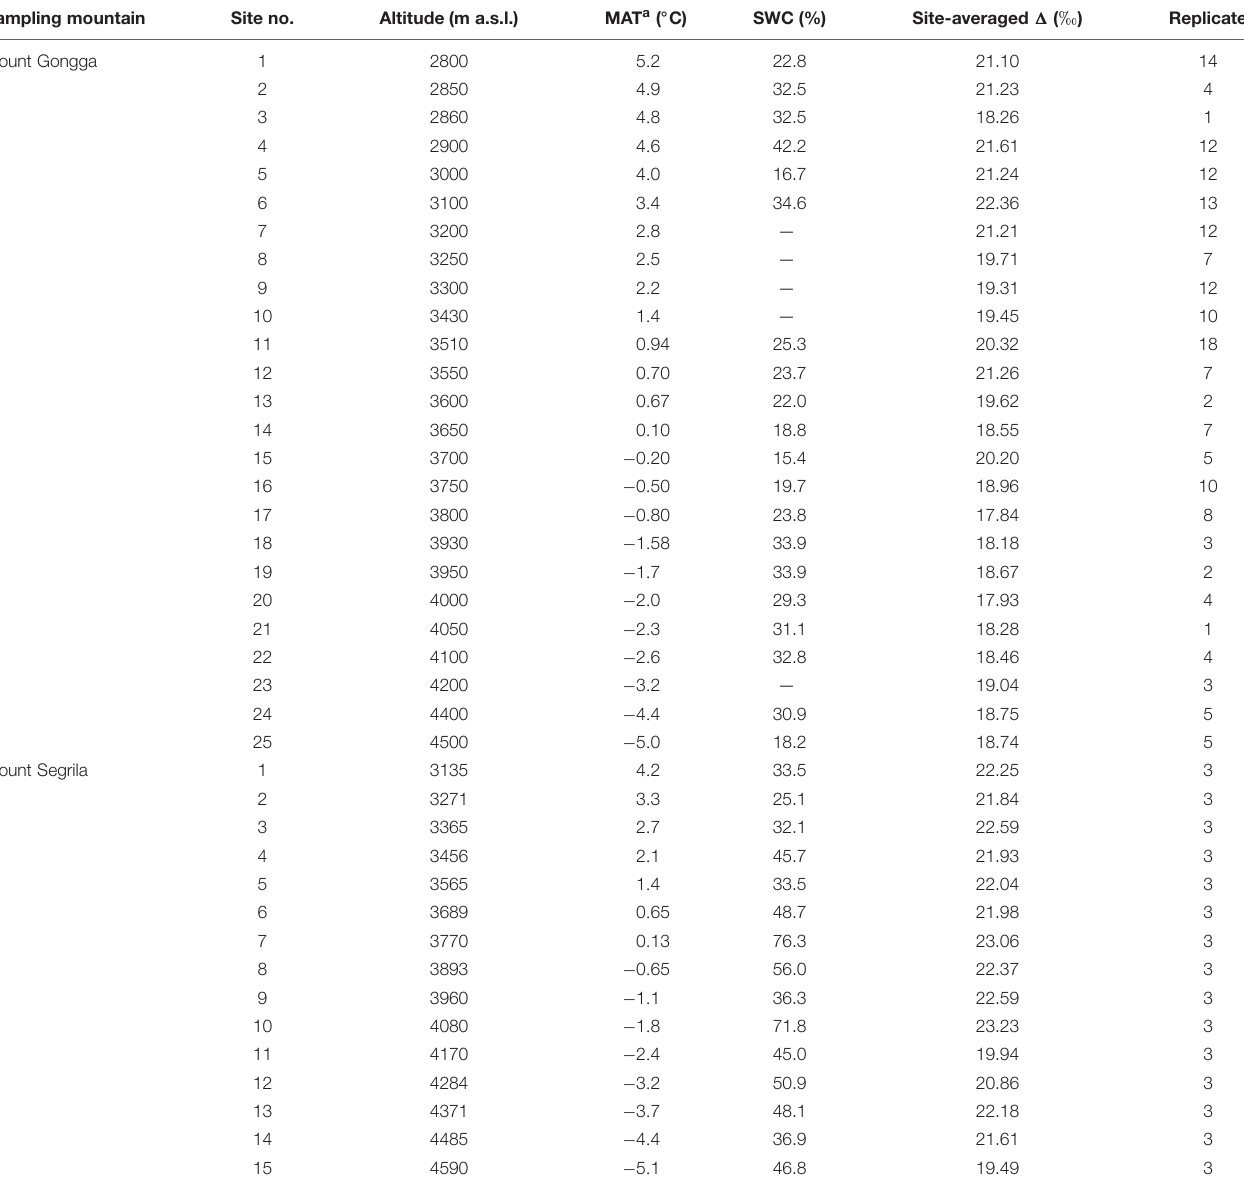
TABLE 1 | Descriptions of climatic condition, dominant vegetation type, and site-averaged plant carbon isotope discrimination value ( (cid:2) ) of different sampling sites on Mount Gongga and Mount Segrila. Sampling mountain Site